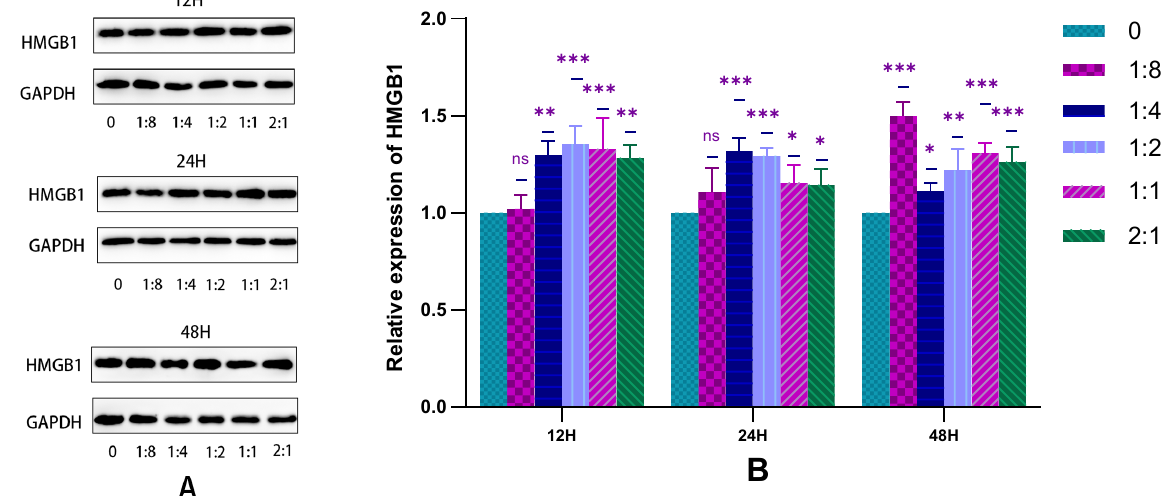
Figure 5. In the cell co-culture system, the WB detection map of HMGB1 protein secreted by HSFs. ( A ) The WB map of HMGB1 protein secreted by HSFs after cell co-culture for 12 h, 24 h, and 48 h. ( B ) The statistical results of relative expression of HMGB1 protein secreted by HSFs. ns: p > 0.05, *: p < 0.05, **: p < 0.01, ***: p <